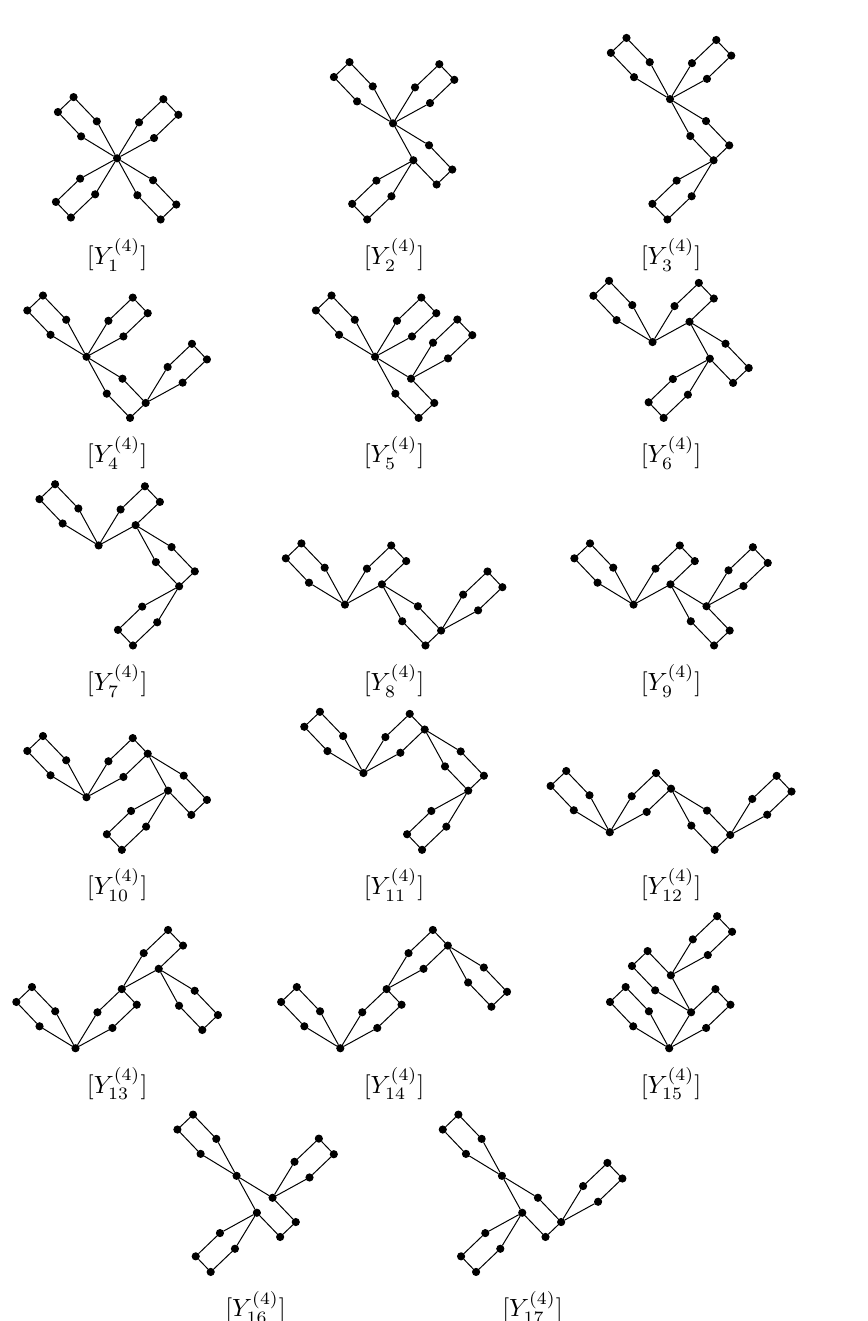
Figure 3. The 17 plane 5-gonal cacti. Each corresponds to the indicated cyclic class [ Y (4) (cid:11) ] of extremal Yangian invariants containing the element Y (4) (cid:11) given in (4.1).